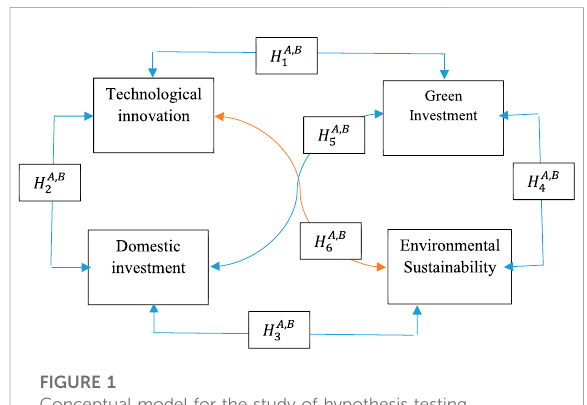
FIGURE 1 Conceptual model for the study of hypothesis